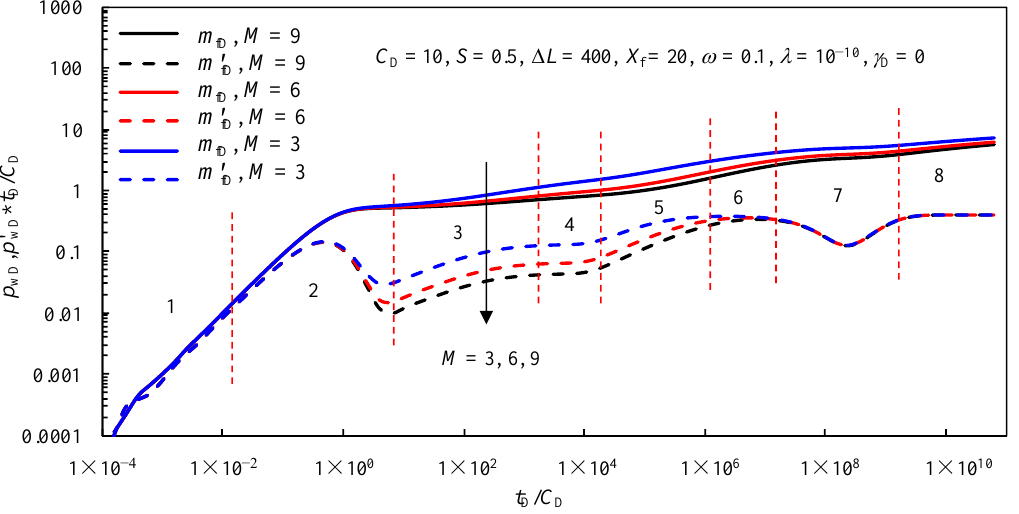
Figure 8. The effect of the number of transverse fractures on the dimensionless pressure and pressure derivatives of a MFHW in an inter-salt shale oil reservoir.